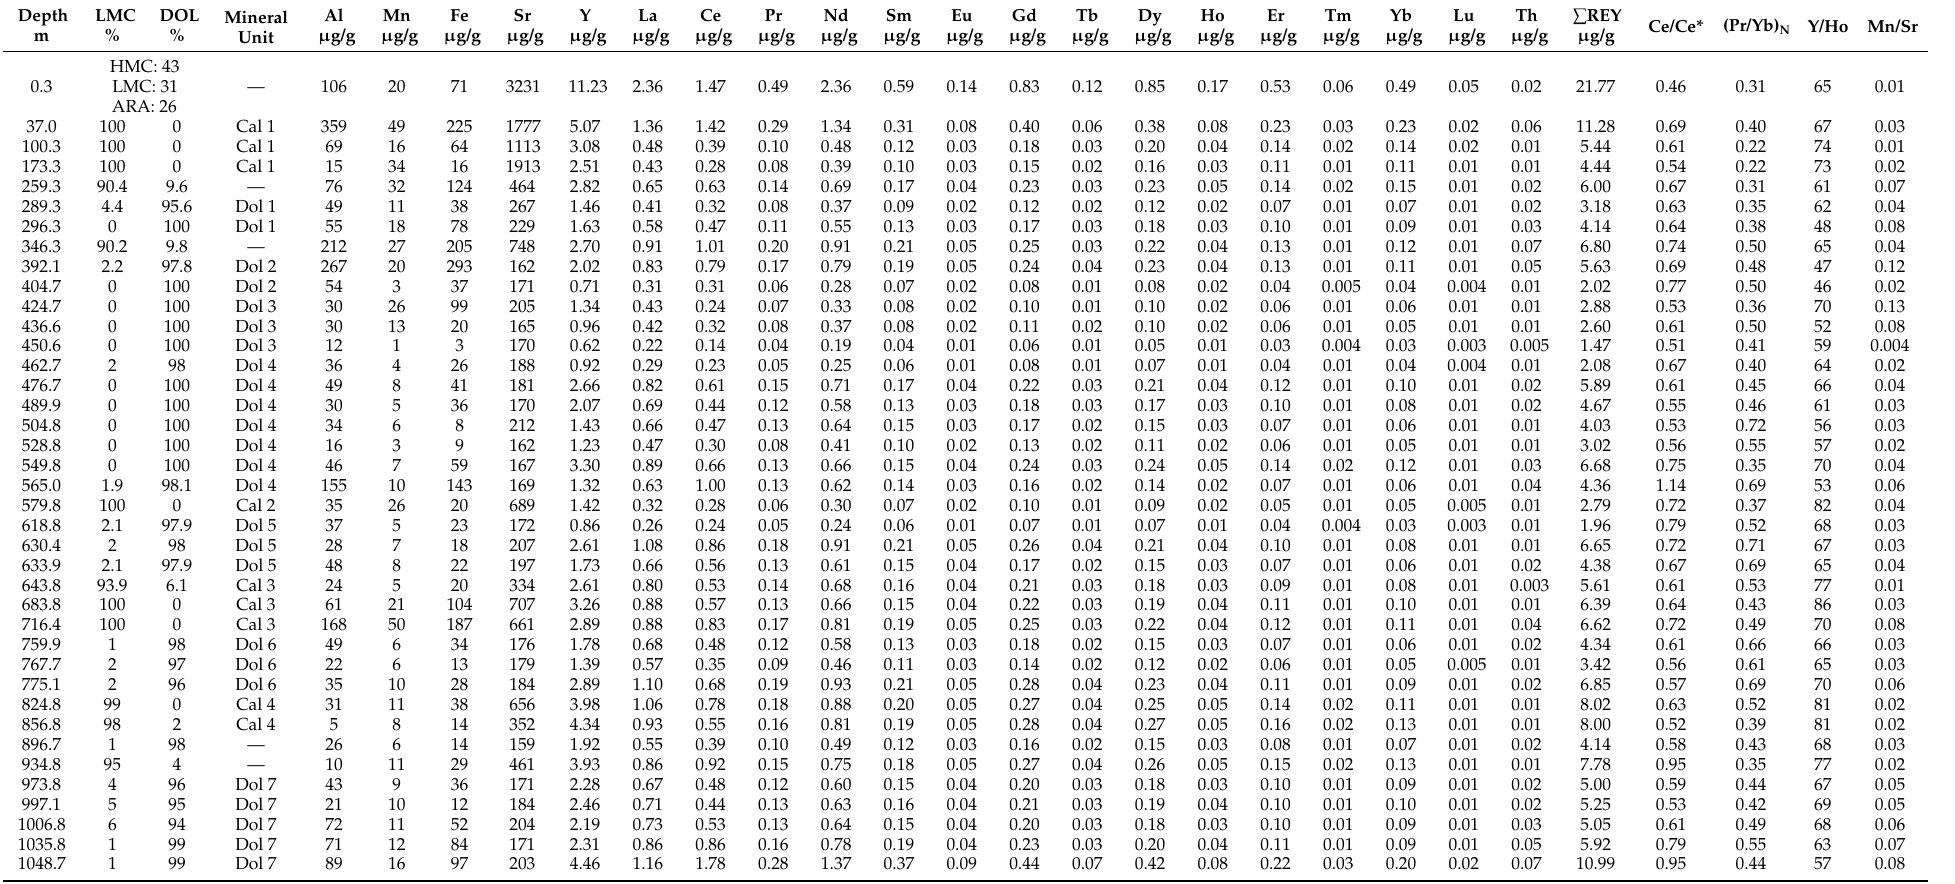
Table 1. Mineralogical and elemental data of the XK-1 core